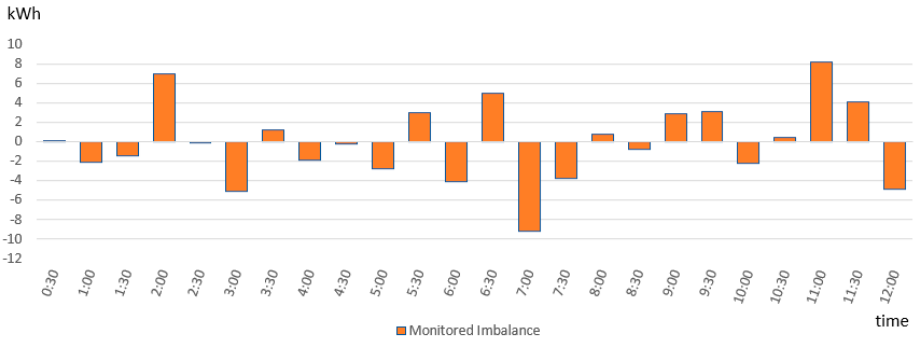
Figure 8. BRP’s total planed vs actual energy consumption.